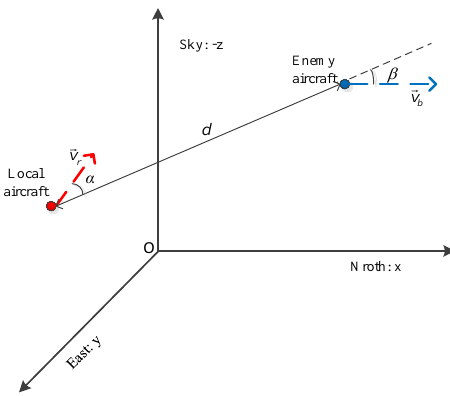
Figure 5. The geometric situation of combat.